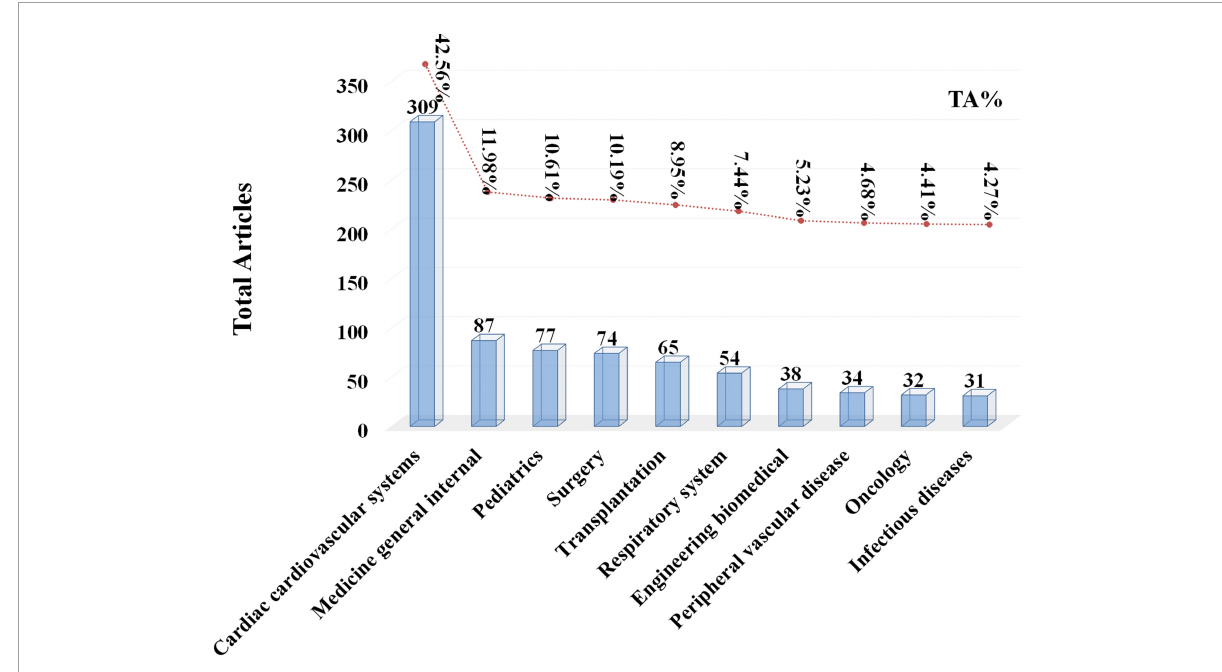
FIGURE7 The top 10 research categories ranked by